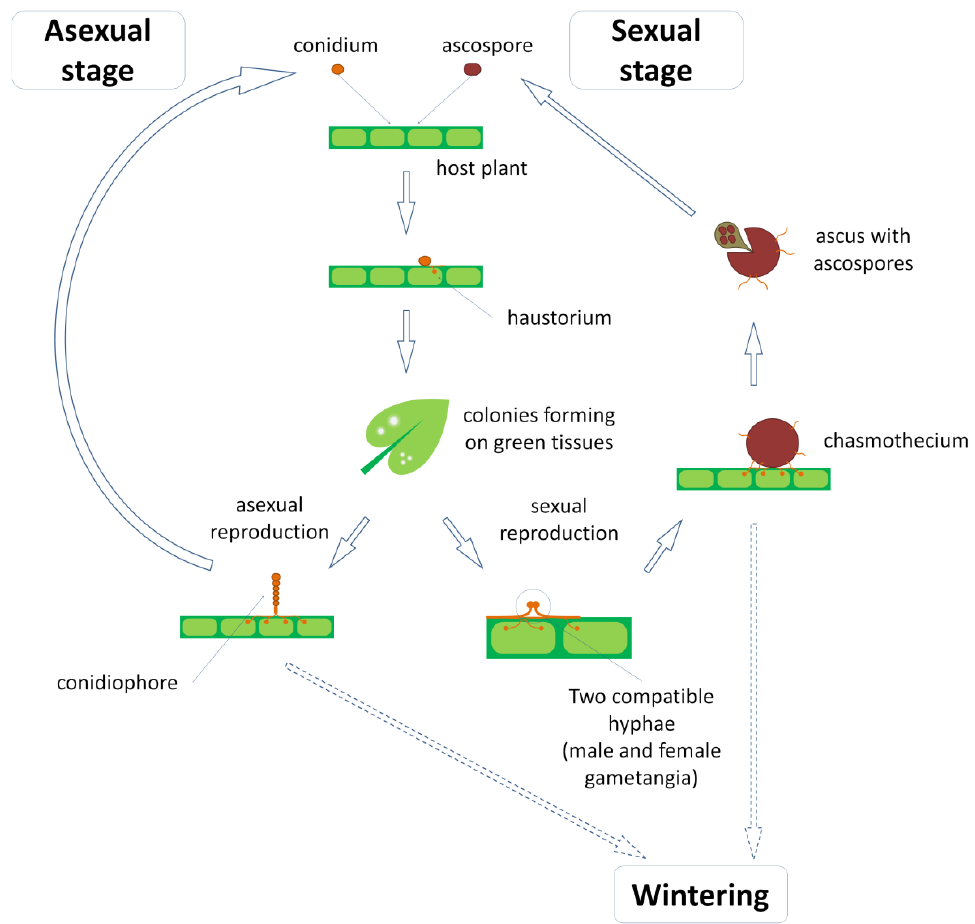
Figure 1. General scheme of powdery-mildew life cycle. Details are explained in text.